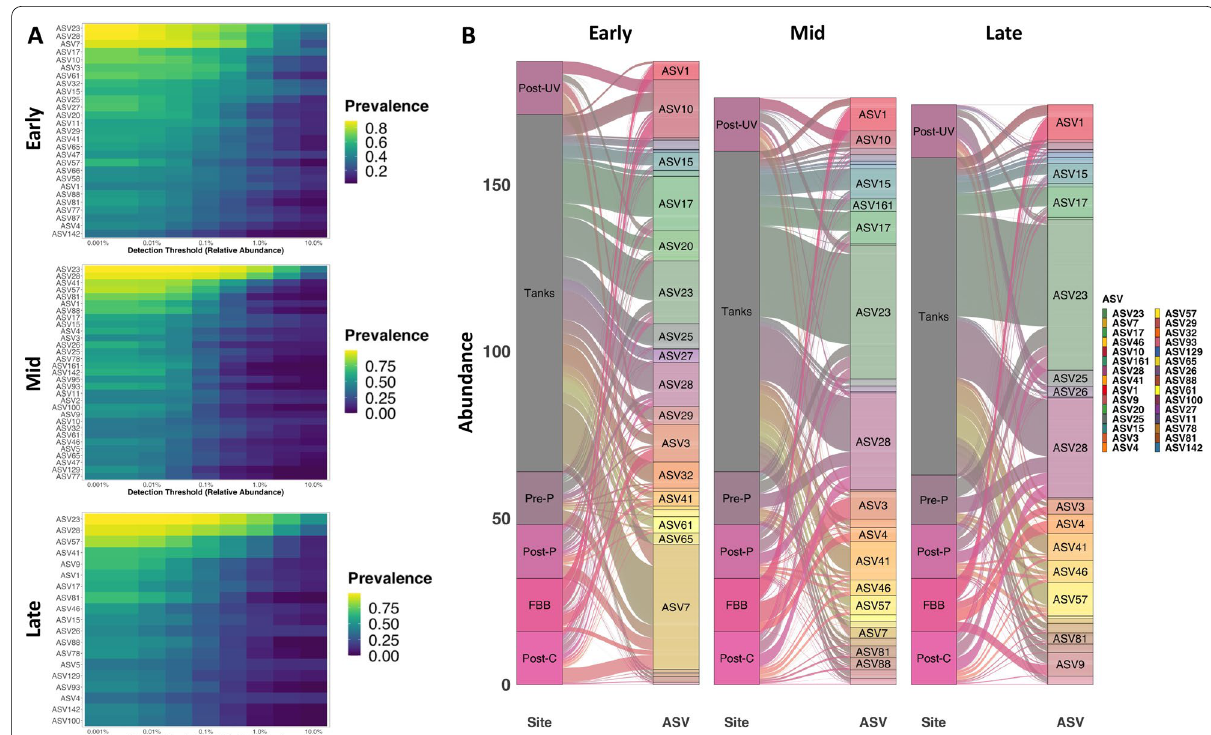
Fig. 5 Limited number of taxa comprise core community throughout equilibration. Heatmaps showing prevalence (legend at right) of core ASVs at increasing thresholds of relative abundance at Early (TP1 to TP4), Mid (TP5 to TP8), and Late (TP9 to TP12) time-points ( A ); alluvial plots showing distribution of core taxa among sample sites within each period of time (legend at right) ( B ). See Additional file 3 for taxonomic identity of core